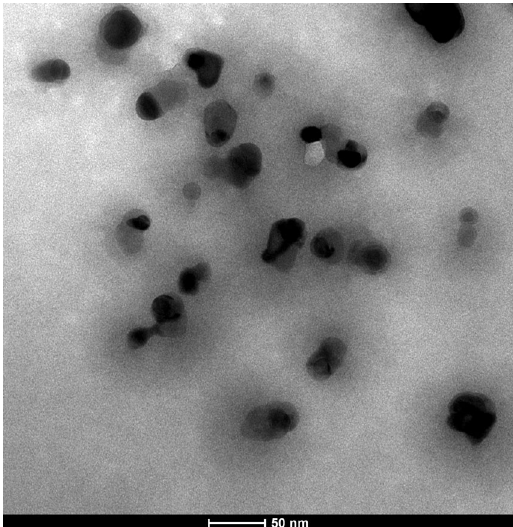
Figure 4. TEM images of AgBr/NPVP. The nanoparticle contains a single core and organic shell; that is, the spherical AgBr is embedded inside the cationic polymer NPVP, and the average diameter of AgBr/NPVP is approximately 30 nm.